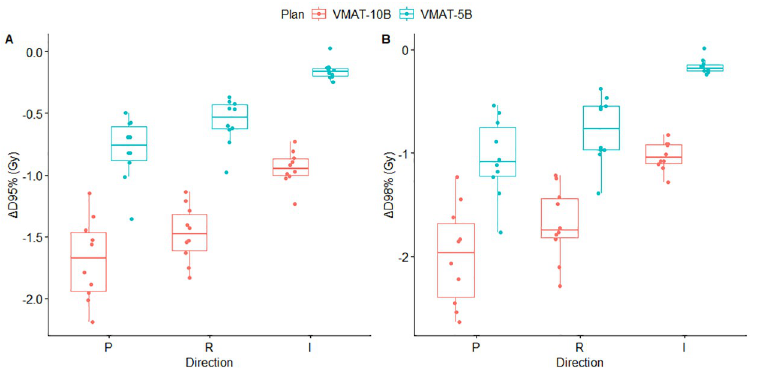
Fig 3. Box plot of Δ D 95% (A) and Δ D 98% (B) in VMAT-5B (green) and VMAT-10B (red) with perturbations in the posterior, right and inferior directions.